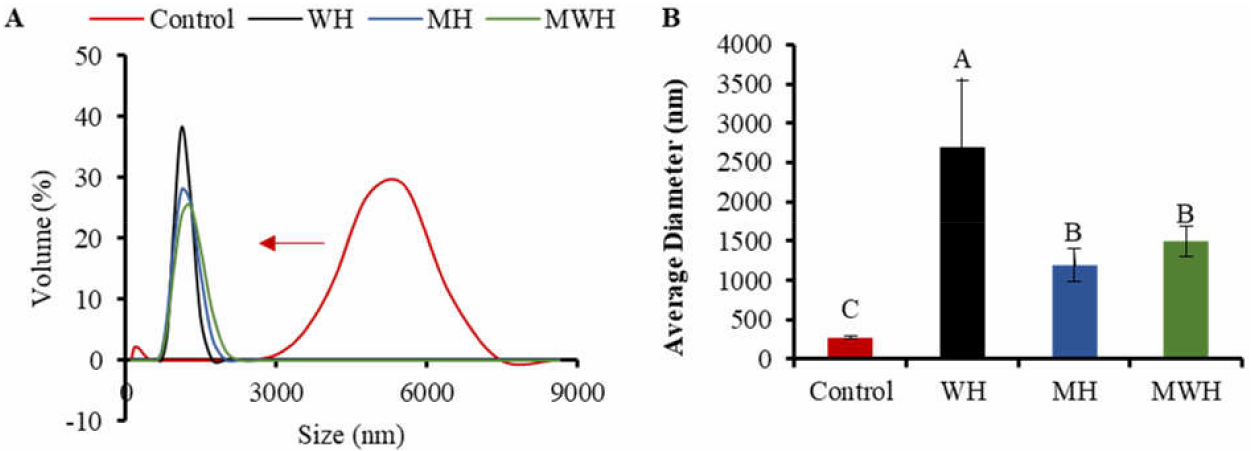
Figure 9. ( A ) The results about particle size distribution of SCM under different heat treatment. ( B ) Average particle size distribution of SCM in different heating modes. Values with different upper-case letters are significantly different ( p <